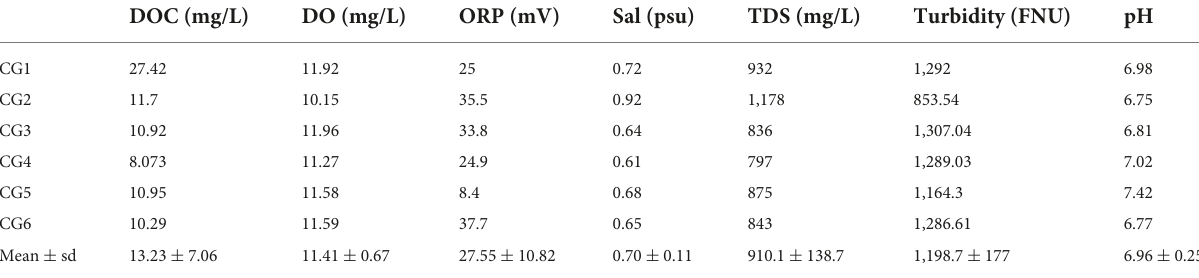
TABLE 2 Physicochemical properties in Chagan